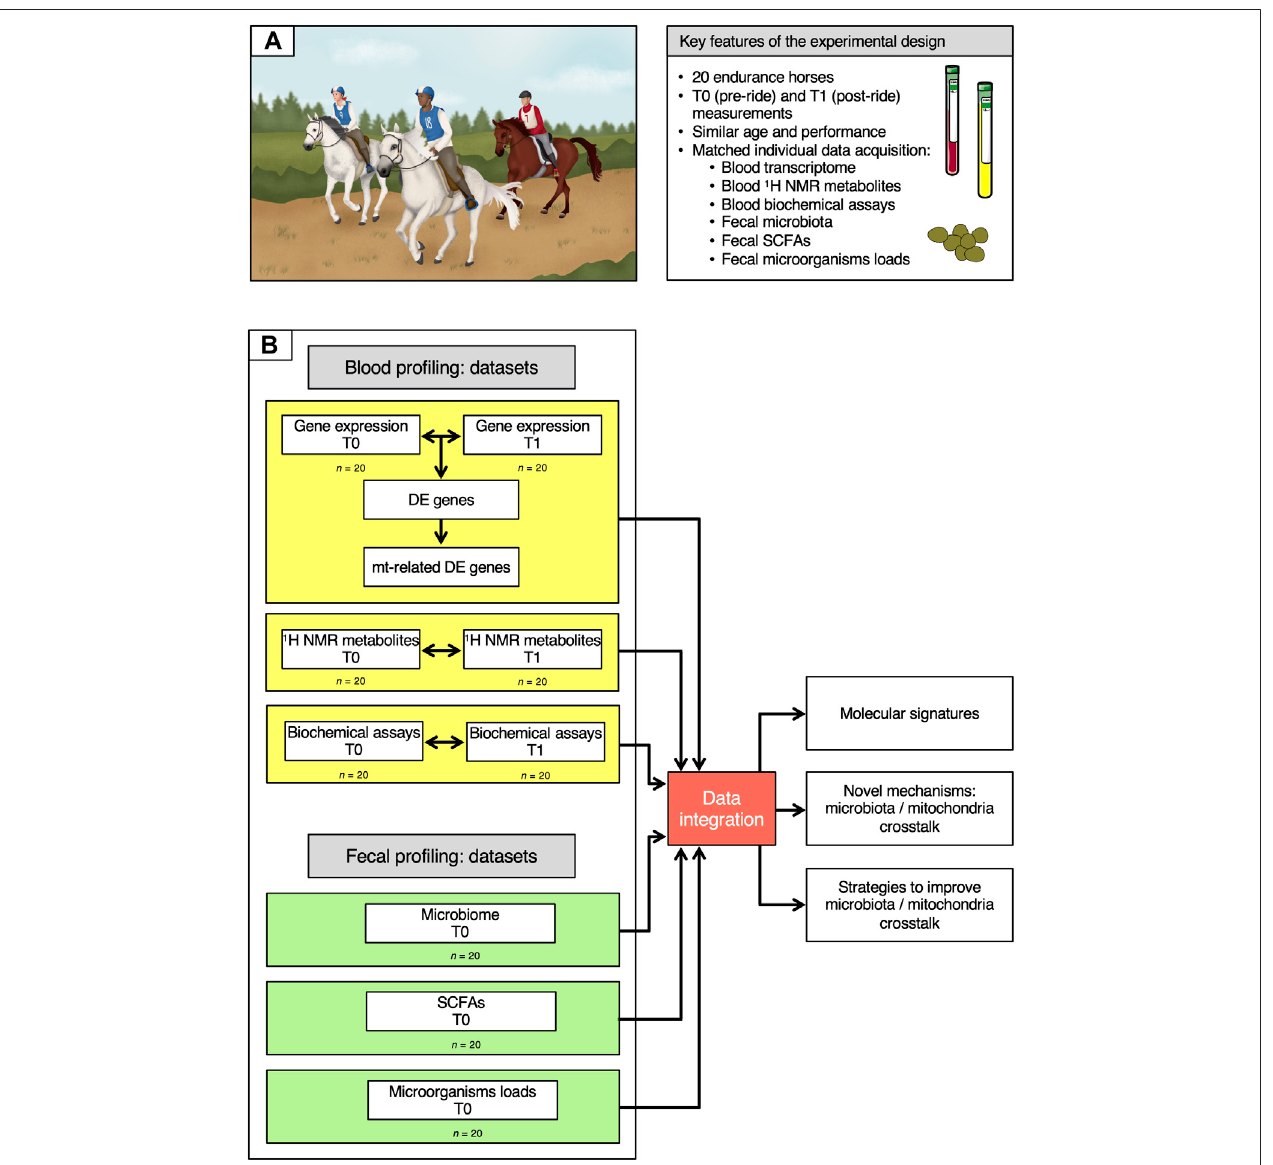
FIGURE1| Descriptionofthecohortandofthedataanalysiswork fl ow. (A) Keyfeaturesoftheexperimentaldesign. (B) Overviewofthedataanalysiswork fl ow.On the left, the six datasets used in the study are depicted, indicating whether they were obtained at T0 and T1 or at T0 only. Data information: written permission for publication of the drawings corresponding to endurance event in the panel A was obtained. In the A panel, the pictures of the blood and plasma tubes were download fromhttps://smart.servier.com.Inallcases,nochangesweremade. ServierMedicalArtbyServierislicensedunderaCreativeCommonsAttribution 3.0Unported